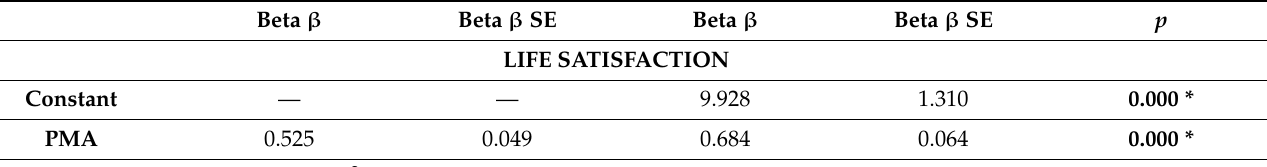
Table 5. Regression models of life satisfaction and perceived stress in light of health